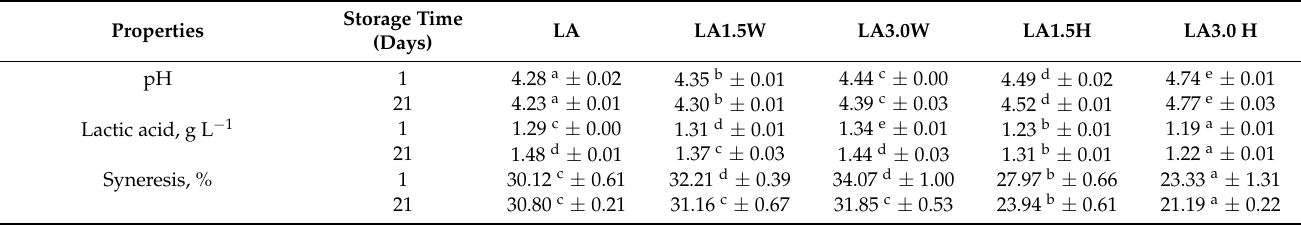
Table 2. Acidity, syneresis, color and texture of sheep’s milk fermented by Lactobacillus acidophilus